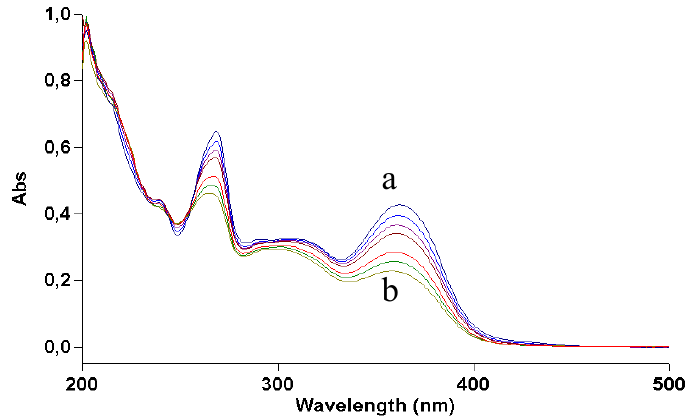
Figure 7. UV absorption spectra of a 2 × 10 − 5 M methanol solution of galangin irradiated with increasing doses of UVA. Curve a, dark; curve b, 70 J/cm 2 .